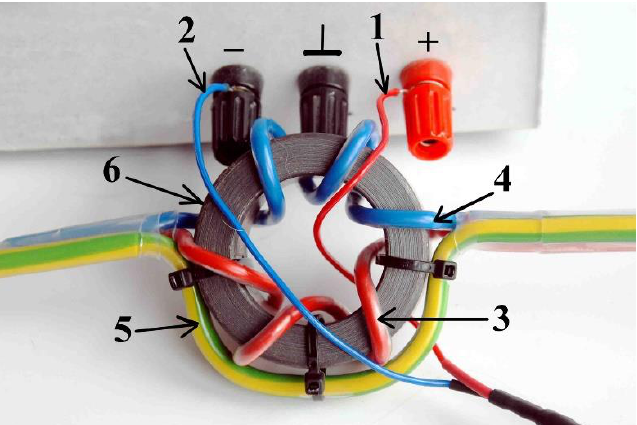
Figure 4. Magnetic coupling circuit: 1 — signal wire AI+; 2 — signal wire AI − ; 3 — phase wire L; 4 — neutral wire N; 5 — protective wire PE; 6 — ferromagnetic core, permalloy, diameter 35/55 mm, height 20 mm.